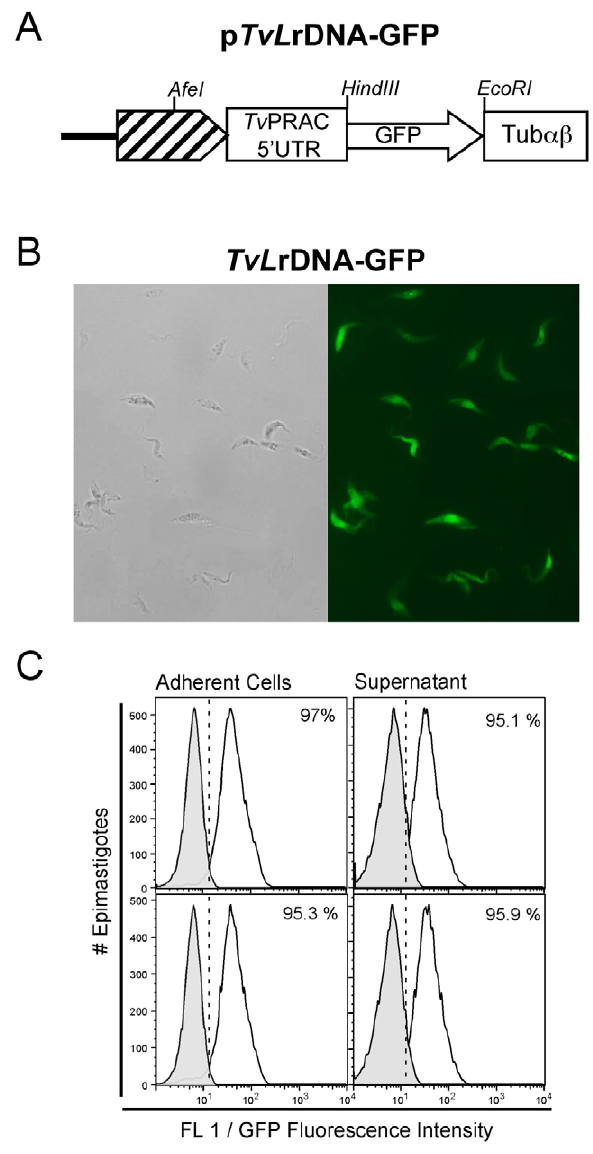
Figure 8. Validation of stably transformed pTvLr DNA-GFP parasites. Schematic representation of pTvLr DNA-GFP vector construct (A); TvLr DNA-GFP parasites from axenic culture supernatants were examined under phase contrast (left panel) and epifluorescence (right panel) microscopy (B). Parasite populations obtained from two independent transfections were cultured and analyzed by flow cytometry. Dead cells were excluded from the acquisition by gating out propidium iodide-stained cells. Parasites were further gated on forward-light scatter/side-light scatter combined gate and the histo- grams represent the frequency of GFP-expressing TvLr DNA-GFP cells (%) as compared to WT, non transformed, control parasites (gray curves)